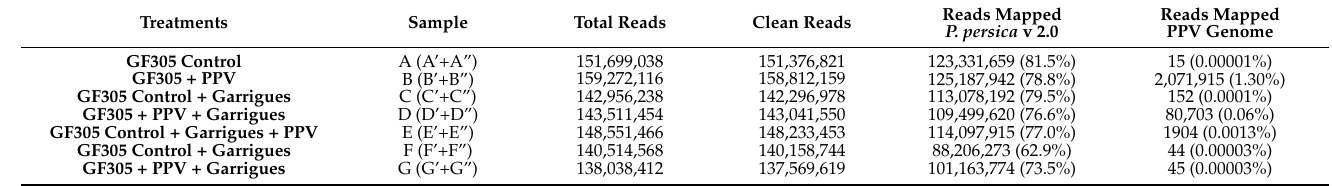
Table 2. Mapping characteristics of samples assayed including the two biological replicates by treatment: control healthy “GF305” peach seedlings (A); PPV-infected “GF305” seedlings showing severe sharka symptoms (B); “GF305” peach seedlings grafted with healthy “Garrigues” (clonal) (C); PPV-infected “GF305” seedlings showing sharka symptoms grafted with healthy “Garrigues” (clonal) (D); healthy “GF305” peach seedlings grafted with healthy “Garrigues” (clonal) which were later inoculated with PPV at the end of the first cycle of evaluation (E). In addition, “Garrigues” almond samples grafted onto healthy (F) and inoculated “GF305” (G) rootstocks were included in the study. In bold type: the sequenced plant material, GF305 = peach; Garrigues = almond. With an inverted comma (’) = single forward; double inverted comma (”) = single